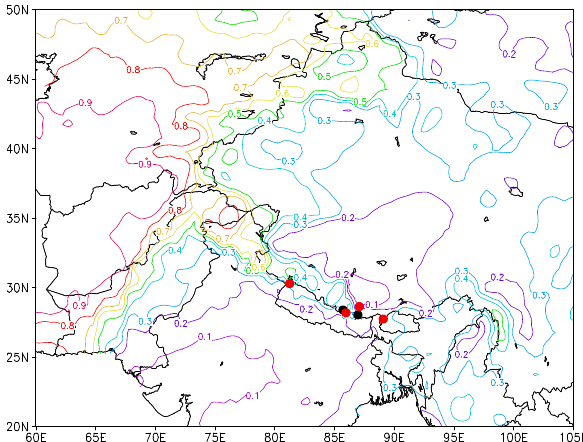
Fig. 4. Map showing the non-monsoon season precipitation ratio to annual precipitation (October–May/annual) along the Himalayas. Reanalysis data are from the monthly long-term mean (1981–2010) precipitation data with a 0.5 ◦ × 0.5 ◦ resolution from the Global Pre- cipitation Climatology Centre (GPCC). Filled red circles are the four weather stations along the Himalayas (from the left to right: Pulan, Nyalam, Dingri, and Pali). The non-monsoon precipitation ratios at the Himalayan stations are generally consistent with those calculated from the GPCC data. Filled black circles are DSP and ER ice cores sites (left: DSP; right: